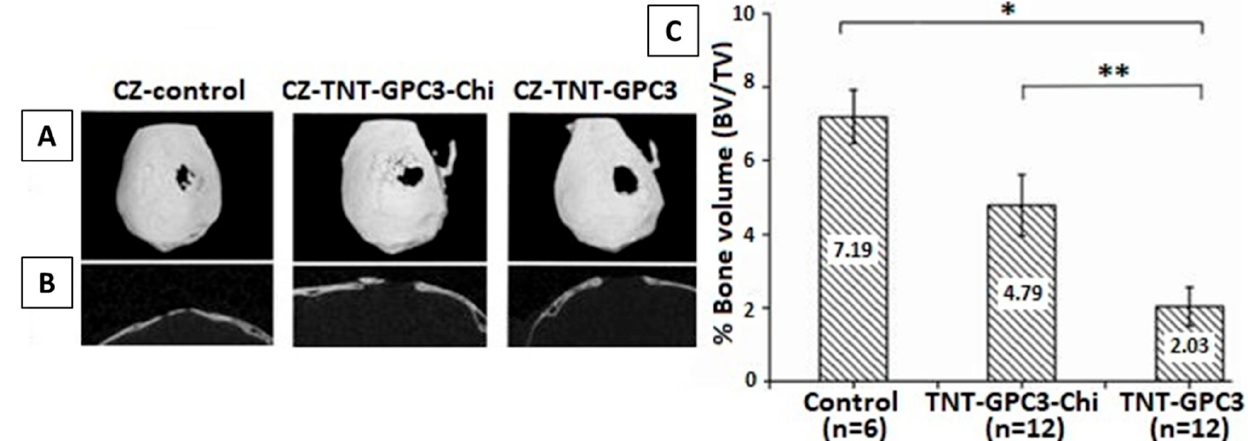
Figure 14. ( A , B ) Micro-CT images from top and side, ( C ) bone volume % plot for regenerated bone in mice. Reproduced from [133], * p < 0.001, ** p < 0.05.